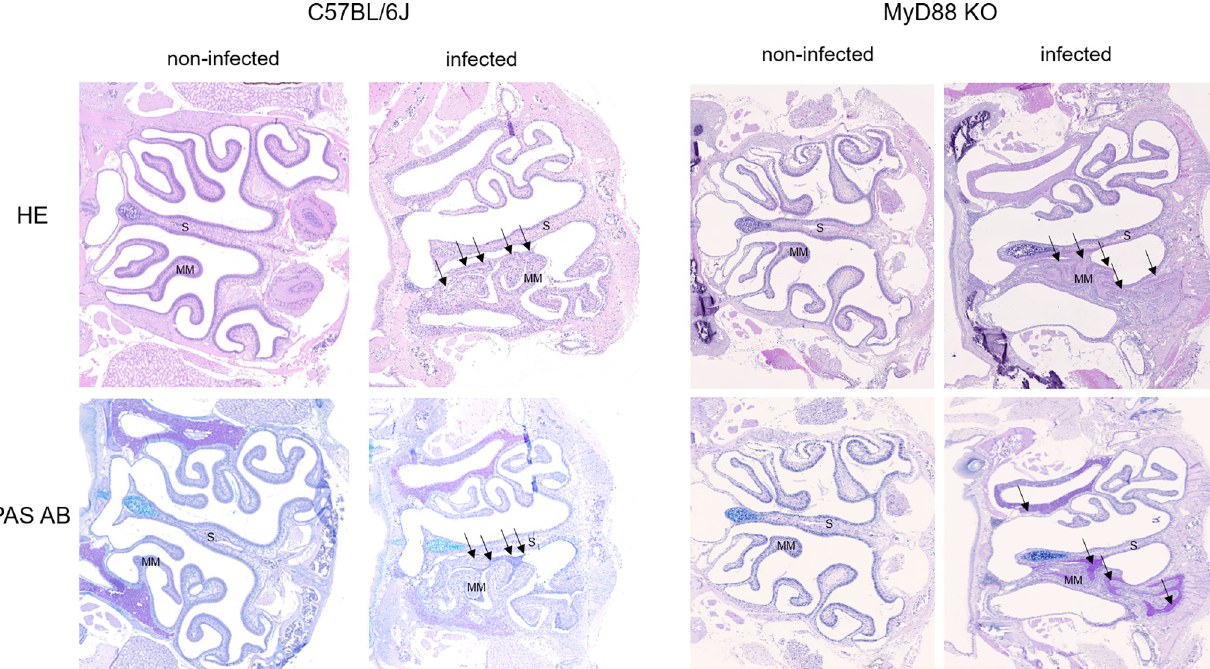
Fig 5. B . pertussis -induced infectious rhinitis pathology in the nasal cavity of MyD88 KO and C57BL/6J mice. Representative images of level 2 coronal sections through the nasal cavity of MyD88 KO and C57BL/6J mice on day 7 after inoculation of nares with 5 μ l of suspension containing 10 7 or 10 9 CFU of B . pertussis bacteria, respectively. Compared to non-infected animals, bacterial colonization in the nasal cavities of infected mice (right panels) elicited mucus secretion and massive mucopurulent exudate accumulation in the cavities of the infected noses (black arrows) as revealed by hematoxylin and eosin staining (HE, upper panels) and Periodic Acid Schiff and Alcian Blue staining for mucus (PAS AB, lower panels). Septum (S), Middle Meatus (MM). Magnification 20x. 3 mice per group were used and representative images of stained sections are shown.